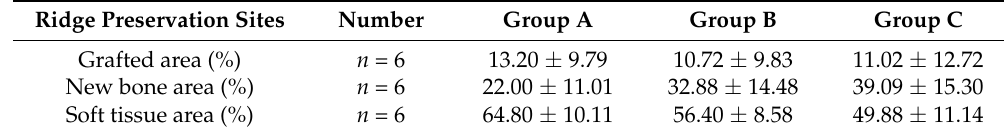
Table 4. Histomorphometric analysis of 3 different groups at 4 month